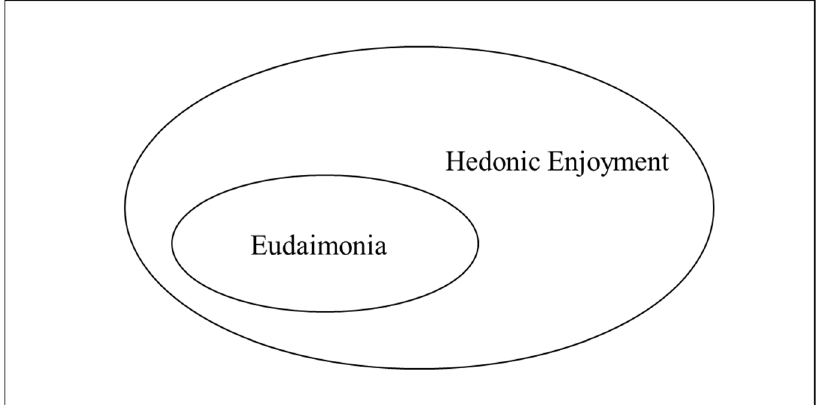
Figure 1. Two Types of Happiness.